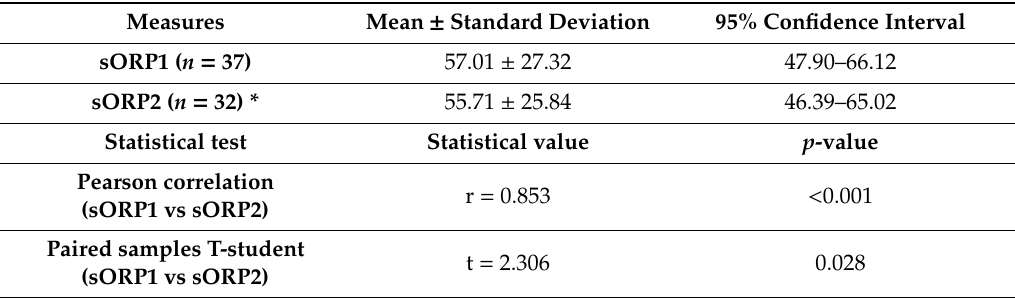
Table 1. Descriptive statistics of first measure (static oxidation-reduction potential 1; sORP 1) and second measure (sORP 2) displayed by the MiOXSYS system and relationship study between them.